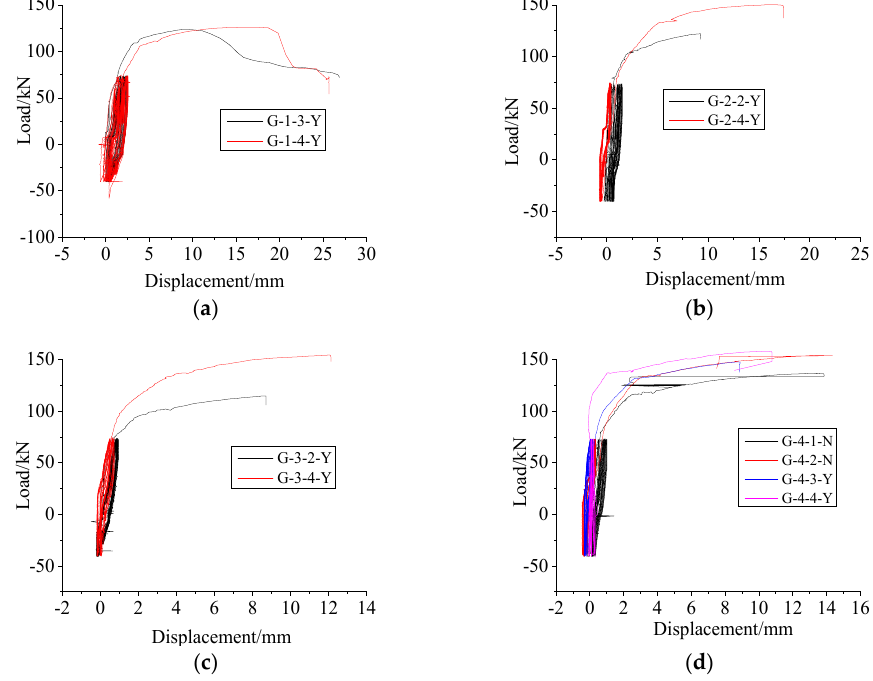
Figure 15. Load–displacement curves under high-stress repeated tension and compression loading (with standard distance ( L + 4 d )). ( a ) Group G − 1, ( b ) Group G − 2, ( c ) Group G − 3, ( d ) Group G − 4.